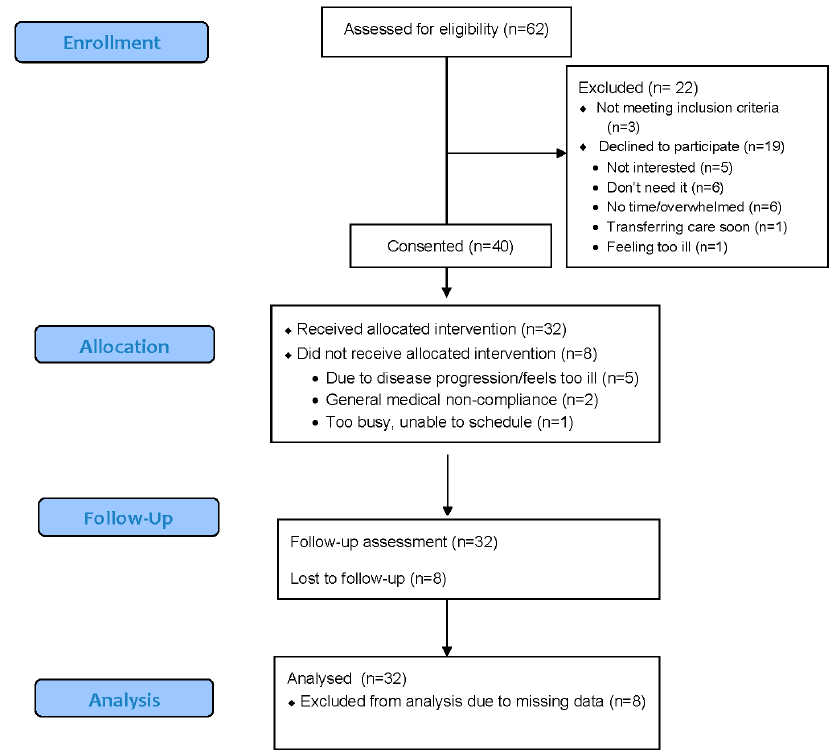
Figure 1. CONSORT flow